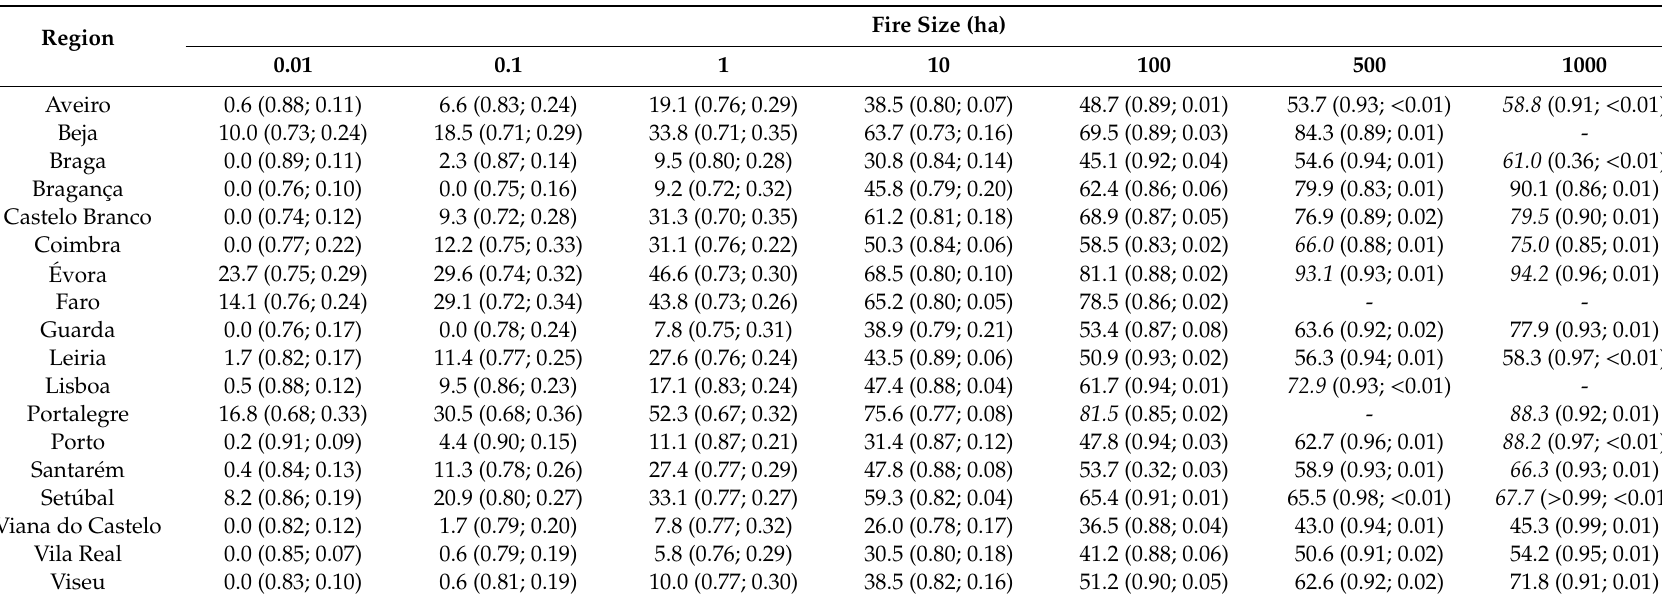
Table 3. FWI thresholds resulting from logistic regression for the daily occurrence of increasingly larger fires in Portugal regions. Numbers within brackets respectively indicate the area under the curve (AUC) and misclassification rate. Italics denote thresholds exceeding the maximum observed FWI. Missing FWI values correspond to thresholds lower than the previous fire-size